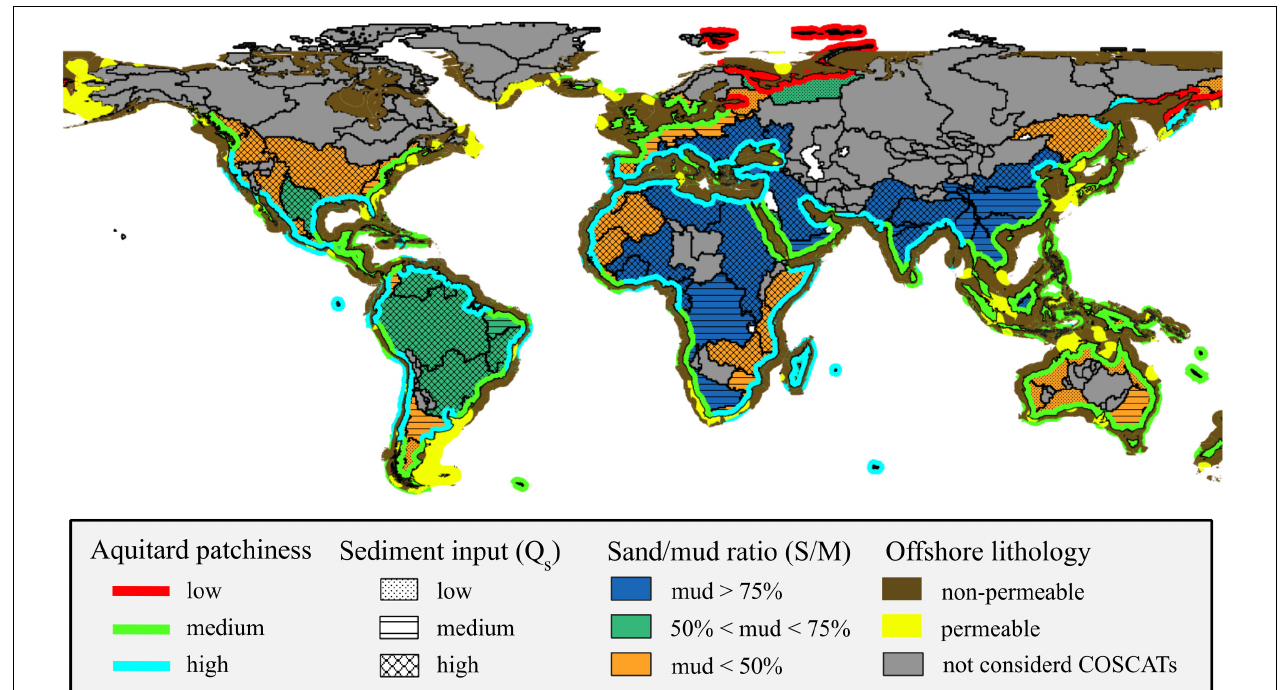
FIGURE 7 | Geological heterogeneity parameterization results for COSCAT regions with CUGS present.